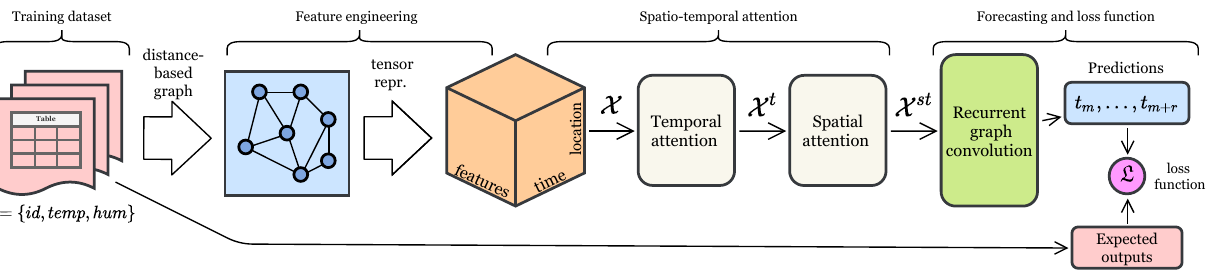
Figure 3. Overview of GRAST-Frost model.